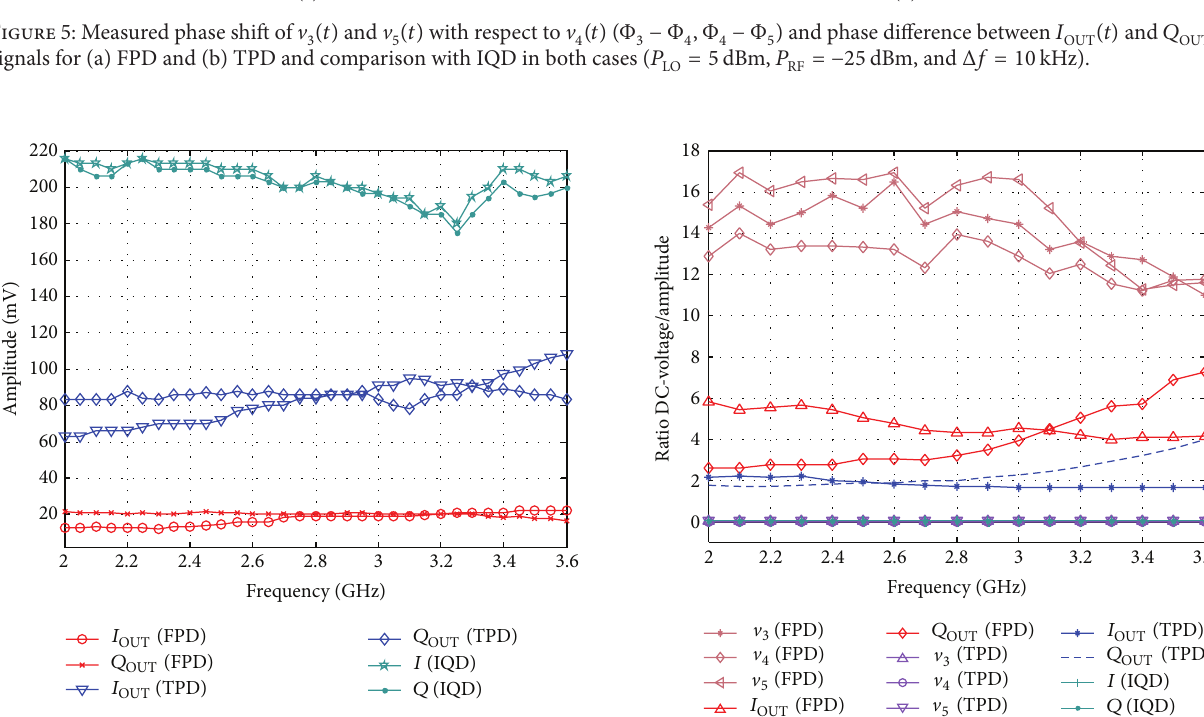
Figure 7: Measured DC offsets suppression performance for FPD and TPD and at the outputs of the 𝐼/𝑄 regeneration circuit ( 𝑃 = −25 dBm, and Δ𝑓 = 10 5 dBm, 𝑃 RF